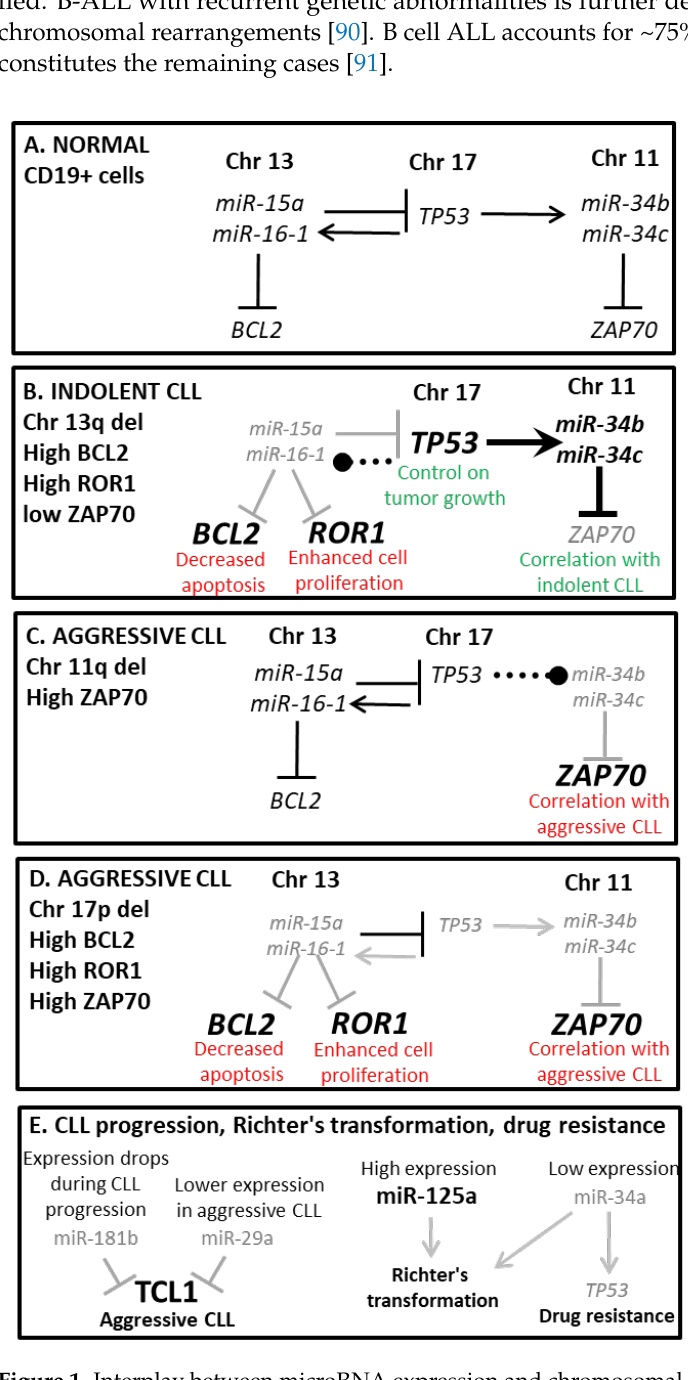
Figure 1. Interplay between microRNA expression and chromosomal aberration in